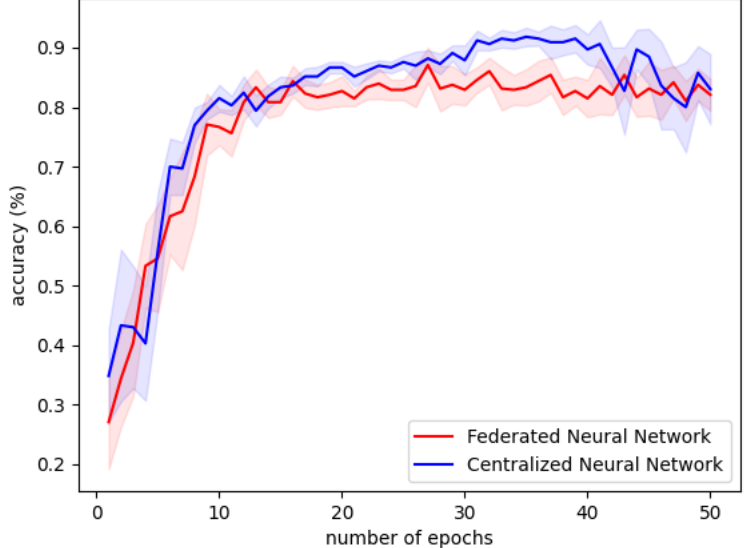
Figure 7. Accuracy per number of epochs for the centralized and federated Neural